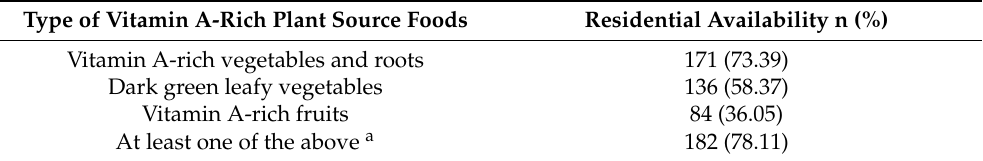
Table 2. Residential availability of plant-based vitamin A-rich food groups in Addis Ababa (n = 233). Type of Vitamin A-Rich Plant Source Foods Residential Availability n (%) Vitamin A-rich vegetables and